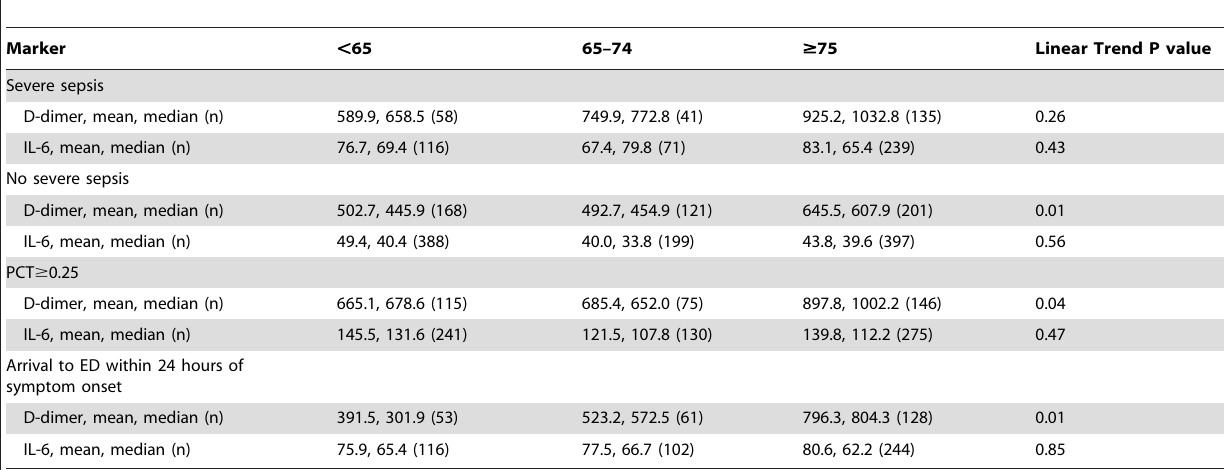
Table 4. Day 1 mean and median levels of D-dimer (ng/ml) and IL-6 (pg/ml) stratified by severe sepsis, PCT, and those who arrived to ED within 24 hours of symptom onset.